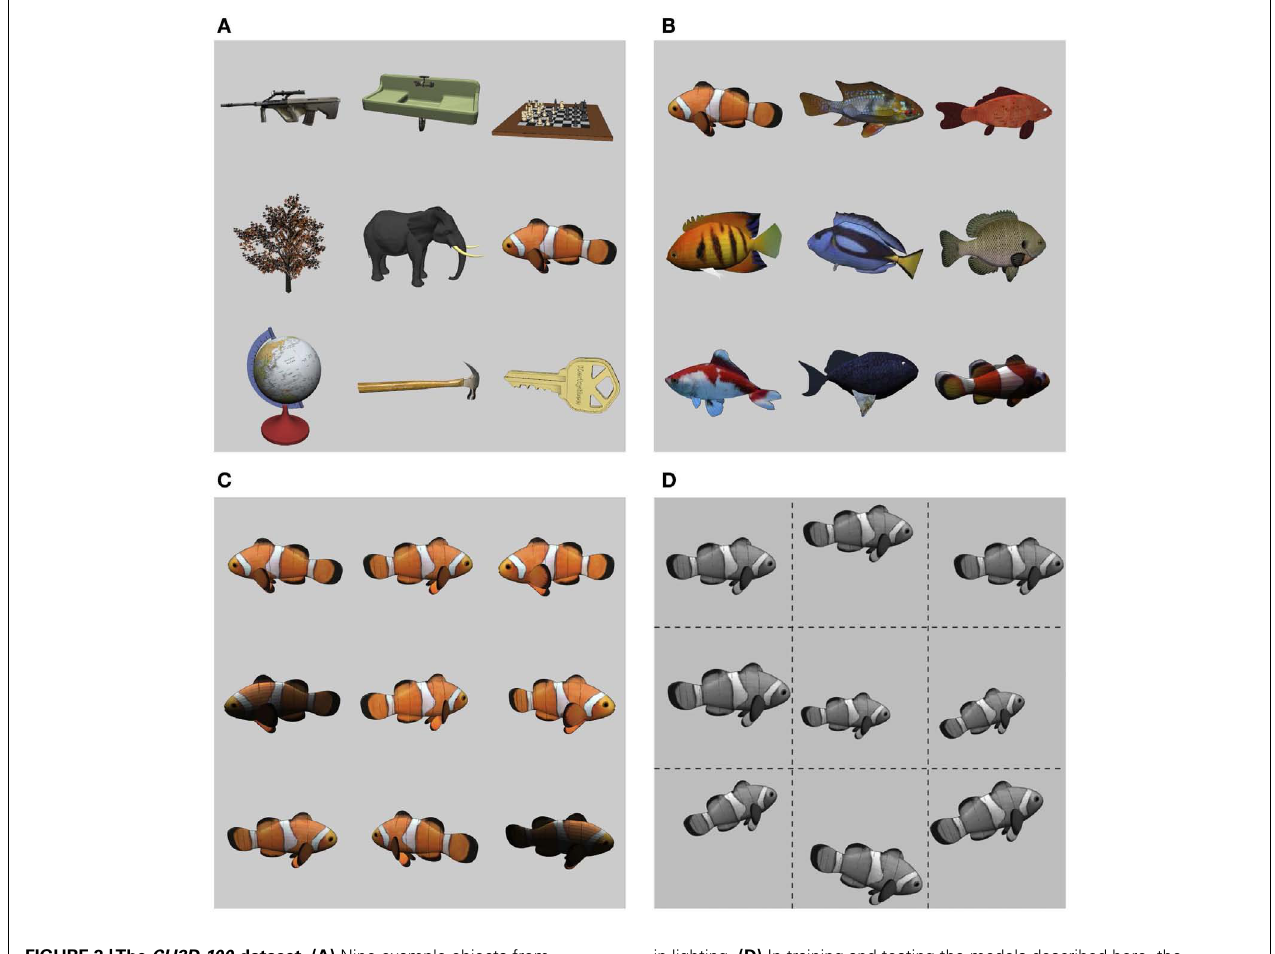
FIGURE 2 |The CU3D-100 dataset. (A) Nine example objects from the 100 CU3D categories. (B) Each category is further composed of multiple, diverse exemplars (average of 9.42 exemplars per category). (C) Each exemplar is rendered with 3D (depth) rotations and variability